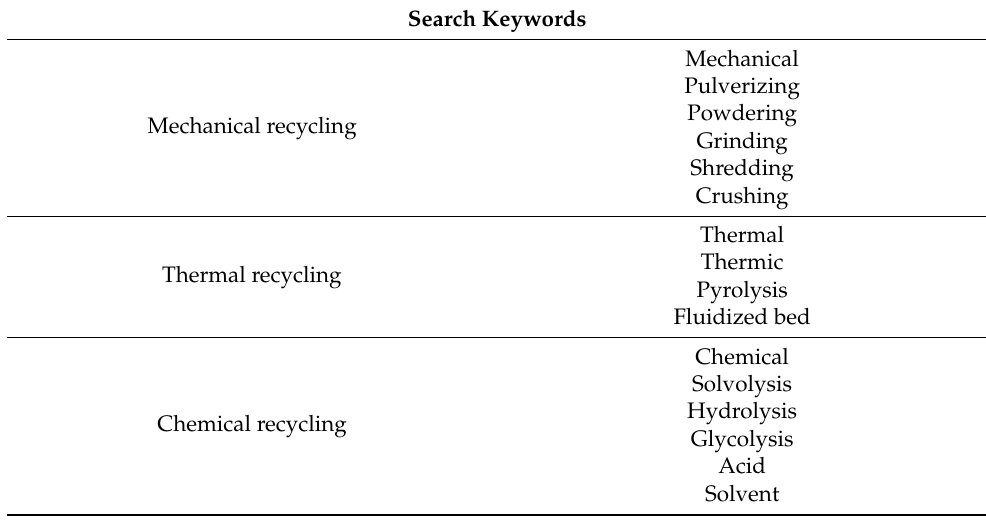
Table A2. Search keywords for identifying the patent pool of each recycling macro-category. Search